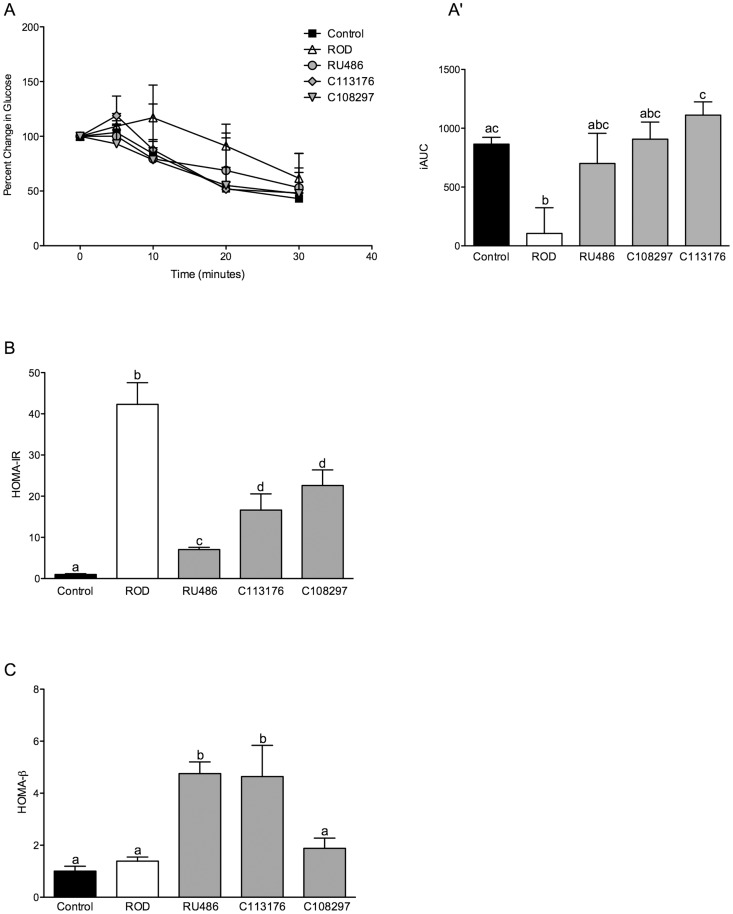
Peripheral insulin sensitivity and β-cell function is enhanced with RU486 and C113176 administration.Percent change of blood glucose levels (mM) relative to individual fasting blood glucose at 5, 10, 20 and 30 minutes post insulin i.p. injection using a handheld glucometer (A). The glucose AUC was measured by the net inverse glucose AUC during the ITT (A′). HOMA-IR index was used to measure whole-body insulin resistance (B). HOMA-β index was used to measure pancreatic β-cell function (C). Bars that do not share similar letters denote statistical significance, p<0.05 one-way ANOVA using Tukey's post-hoc test. n = 7–10. All values are means ± SE.